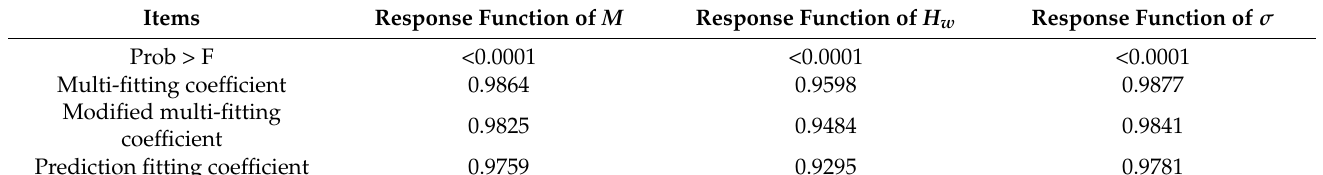
Table 2. The adaptability analysis result.